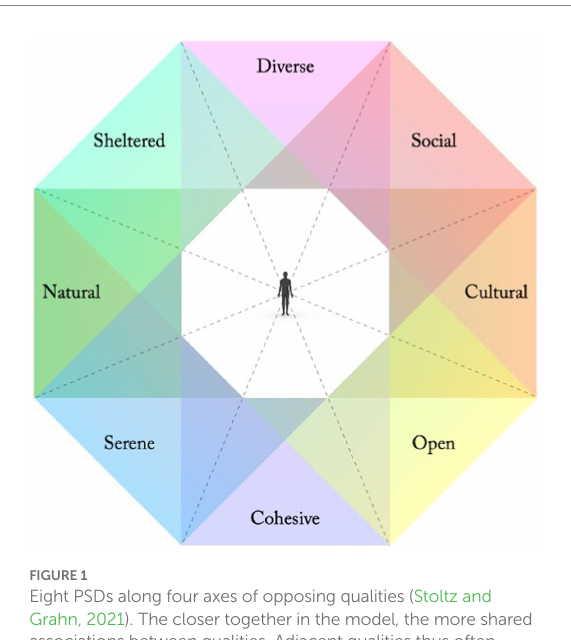
FIGURE 1 Eight PSDs along four axes of opposing qualities (Stoltz and Grahn, 2021). The closer together in the model, the more shared associations between qualities. Adjacent qualities thus often reinforce each other, while opposing qualities might weaken or contradict each